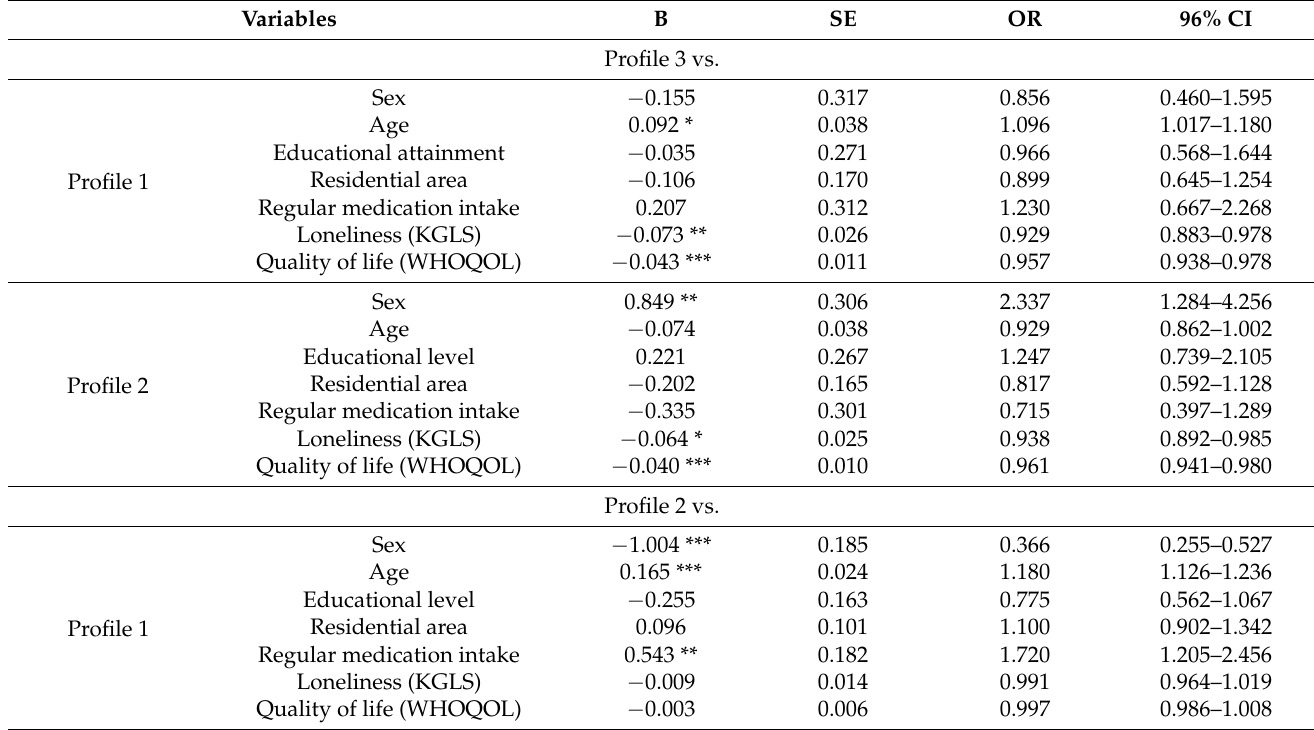
Table 5. Association between lifestyle profiles and other